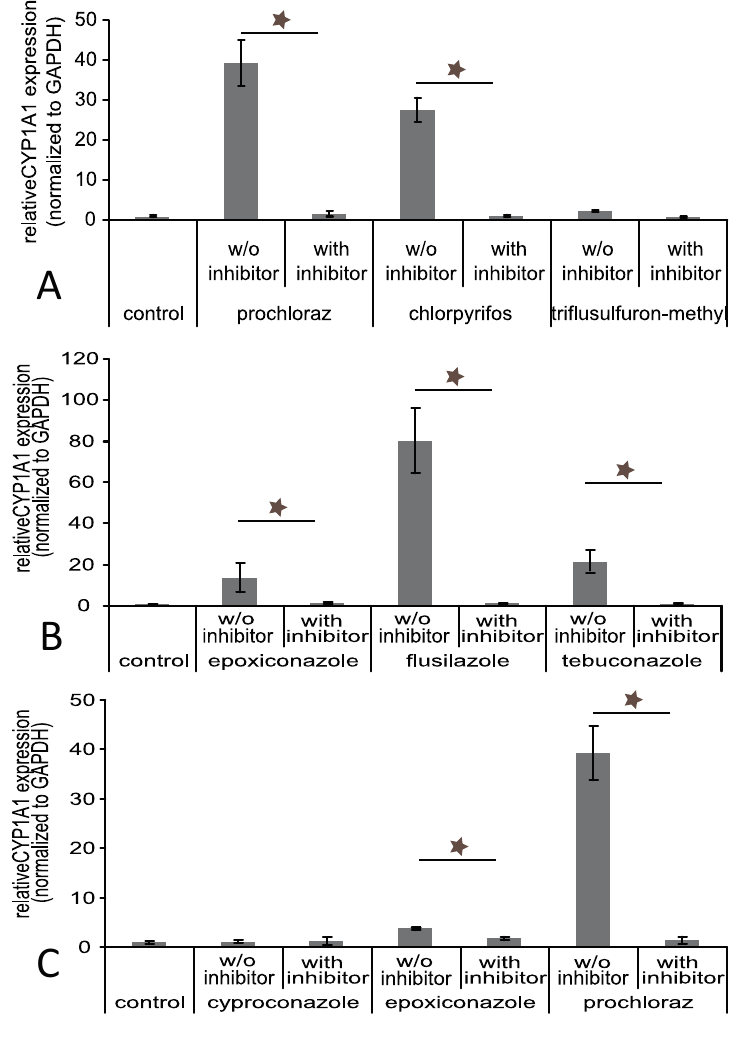
Figure 6. CYP1A1 mRNA expression after substance treatment with or without AhR inhibitor. Jeg-3 cells were grown in 6-well cell culture plates for 24 h. Thereafter, the cells were incubated with 10 µM of the AhR specific inhibitor CH223191 for 4 h before incubation with the substances in total concentrations of 30 and 40 µM as indicated for 48 h individually and in combination: ( A ) 30 µM for epoxiconazole, tebuconazole and flusilazole, ( B ) 40 µM for epoxiconazole, cyproconazole and prochloraz, ( C ) 40 µM for prochloraz, chlorpyrifos and triflusulfuron-methyl. Finally, the RNA was isolated and reverse transcription performed as described. The data represent the mean ± SD for three independent experiments. * Indicates significance with p ≤